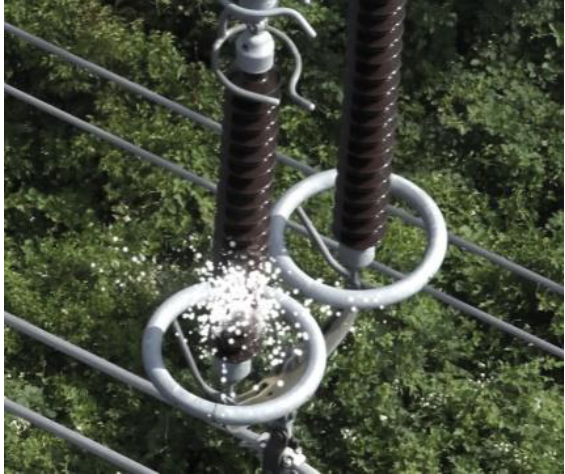
Figure 3: Discharge effects on a powerline (GGS GmbH 2019.)